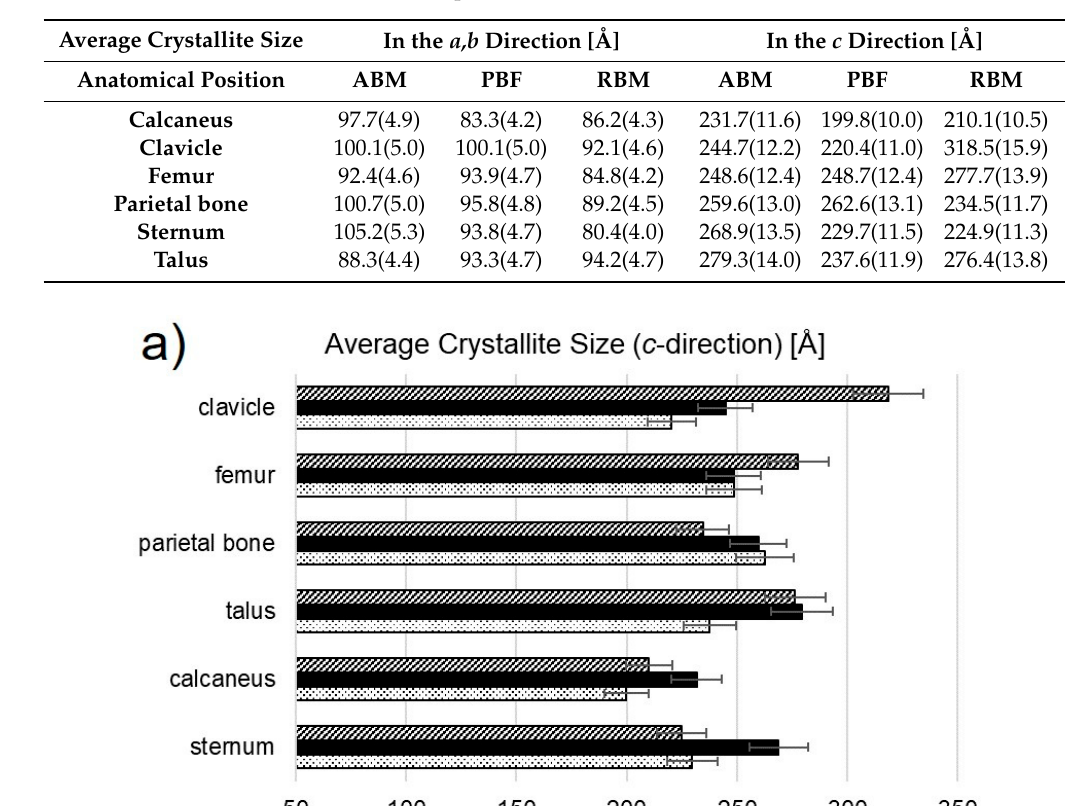
Table 2. Average crystallite size in the a,b direction and in the c direction of human bone bioapatite determined from the Rietveld refinement of XRPD data from human bone assuming a platelet shape model. Error values are indicated in the parentheses.